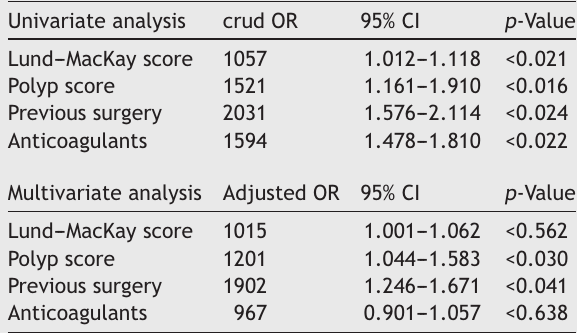
Risk factors for ophthalmic complications during endoscopic sinus